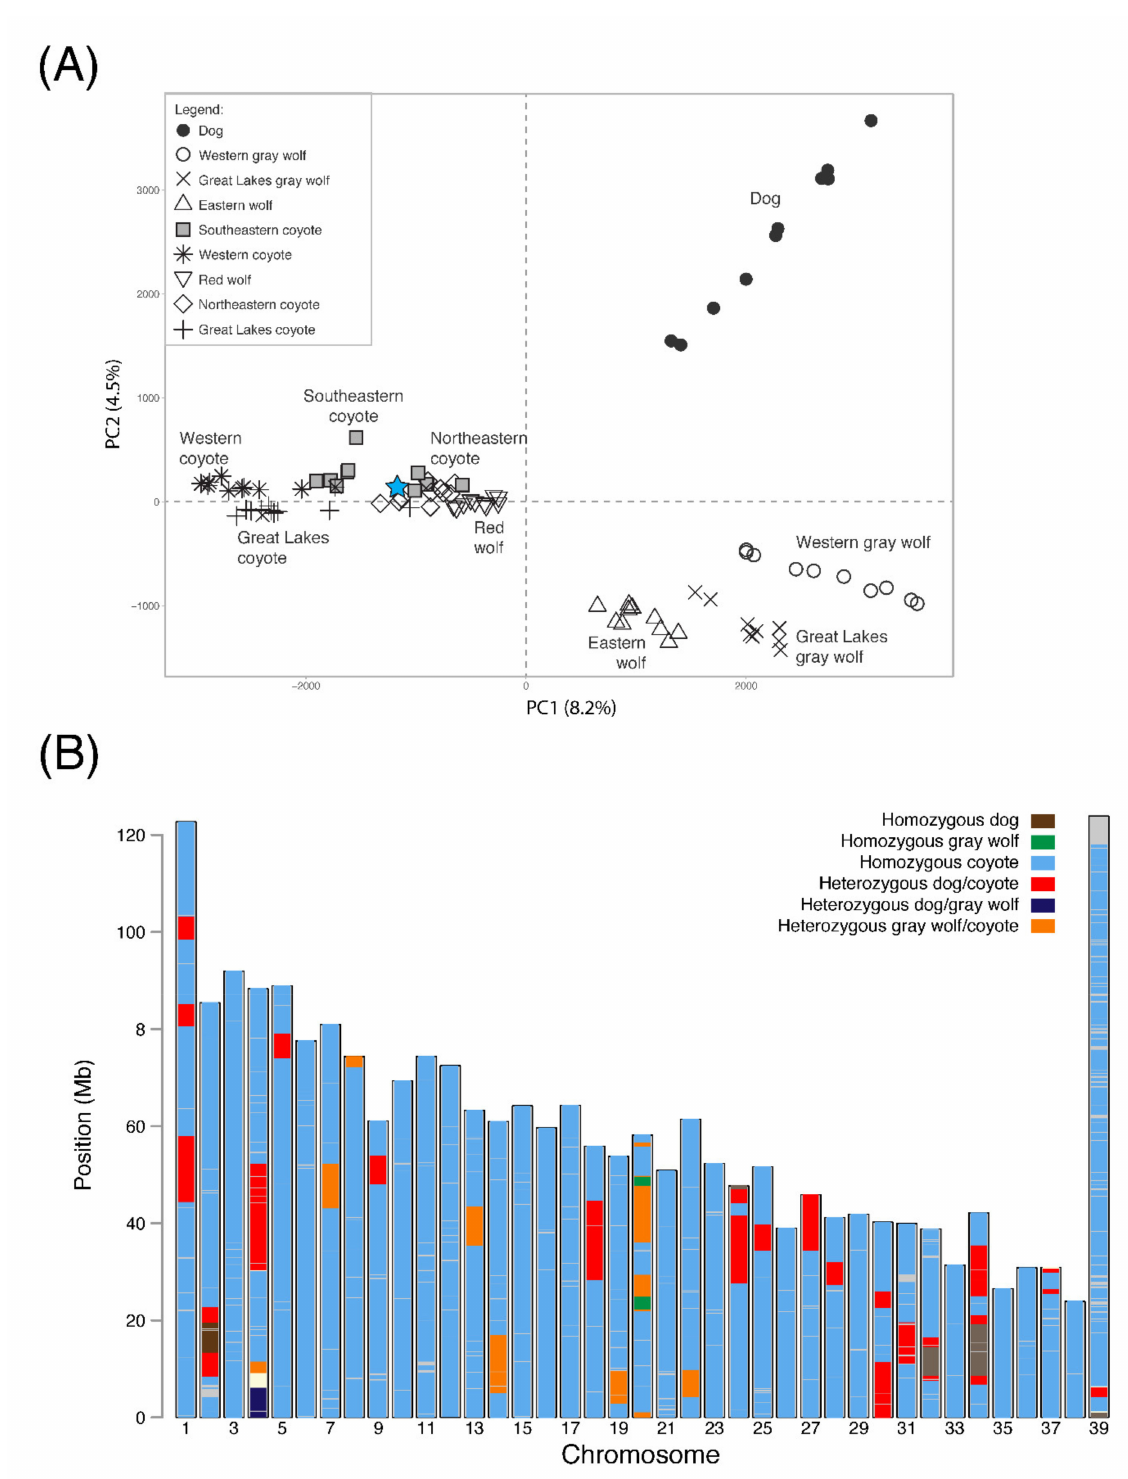
Figure 2. Genomic analysis of Carmine. ( A ) PCA of 105,931 SNP genotypes to cluster Carmine (star) with respect to 90 reference canids of North America. The percentage of variation explained by each component is provided in parentheses. ( B ) Chromosomal-level visualization of the ancestry across the 118,201 SNPs in Carmine’s genome. Ancestry was assigned to three reference canids of North America: domestic dogs, gray wolves (Western and Great Lakes), and coyotes (Western, Southeastern, Northeastern, and Great Lakes). The ancestry at each SNP was designated as either homozygous or heterozygous for the ancestry-informative allele. For detailed ancestry block information, see Table